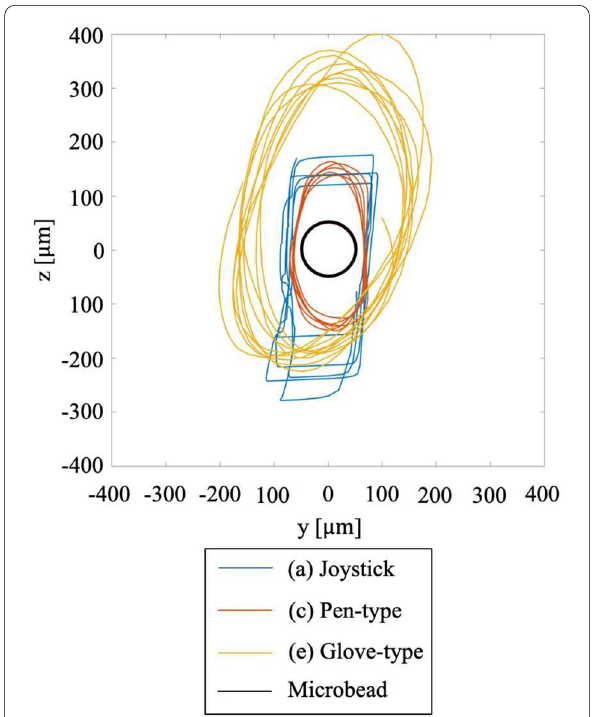
Fig. 16 Trajectories in the yz -plane with 2D image presentation in the evaluation of operation speed